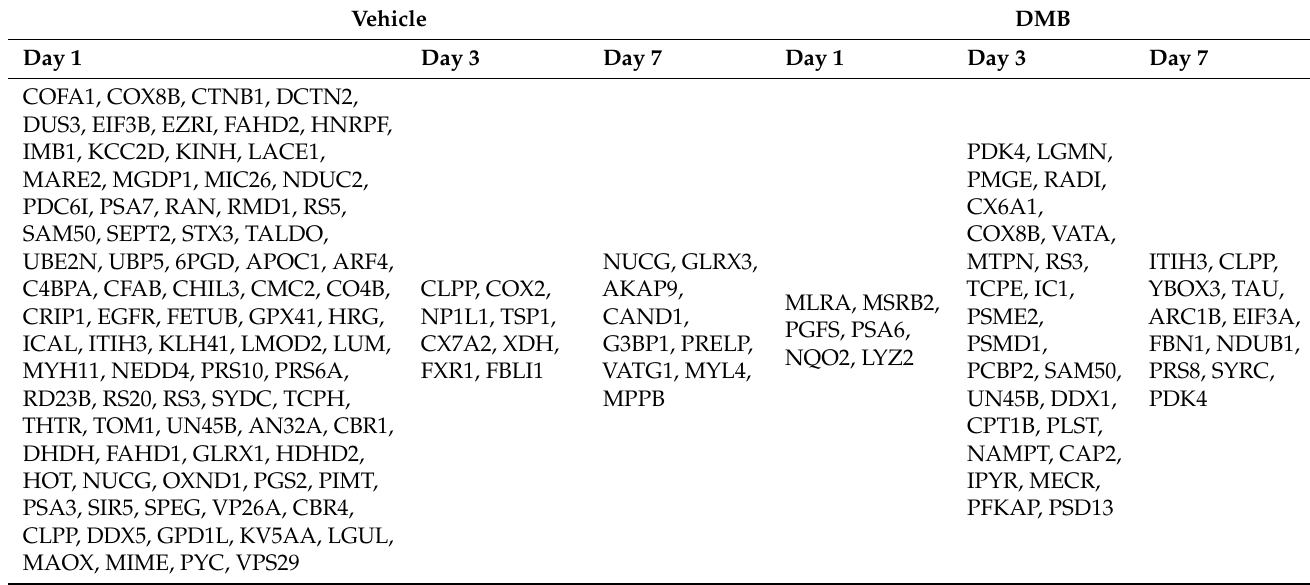
Table 2. List of unique proteins identified in each group in the cross-comparative analysis.